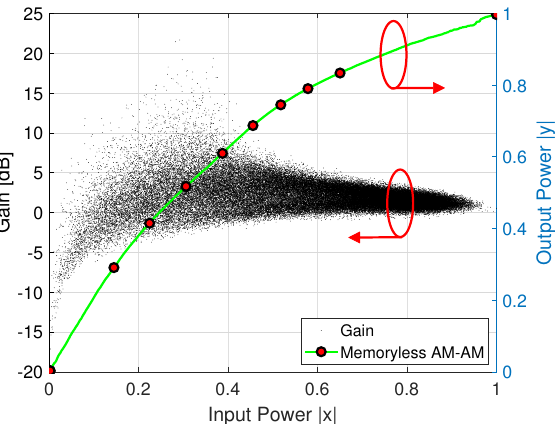
Figure 10. Gain for the normalized input and output signal vs. memoryless AM–AM characteristic.